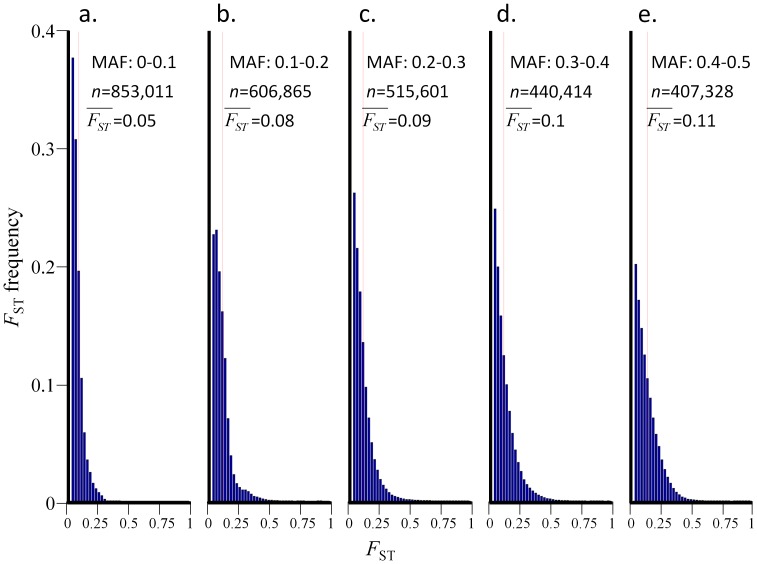

F
ST distributions for five MAF groups (a–e).The histograms show the F
ST values for five allele frequency groups divided by their MAF.